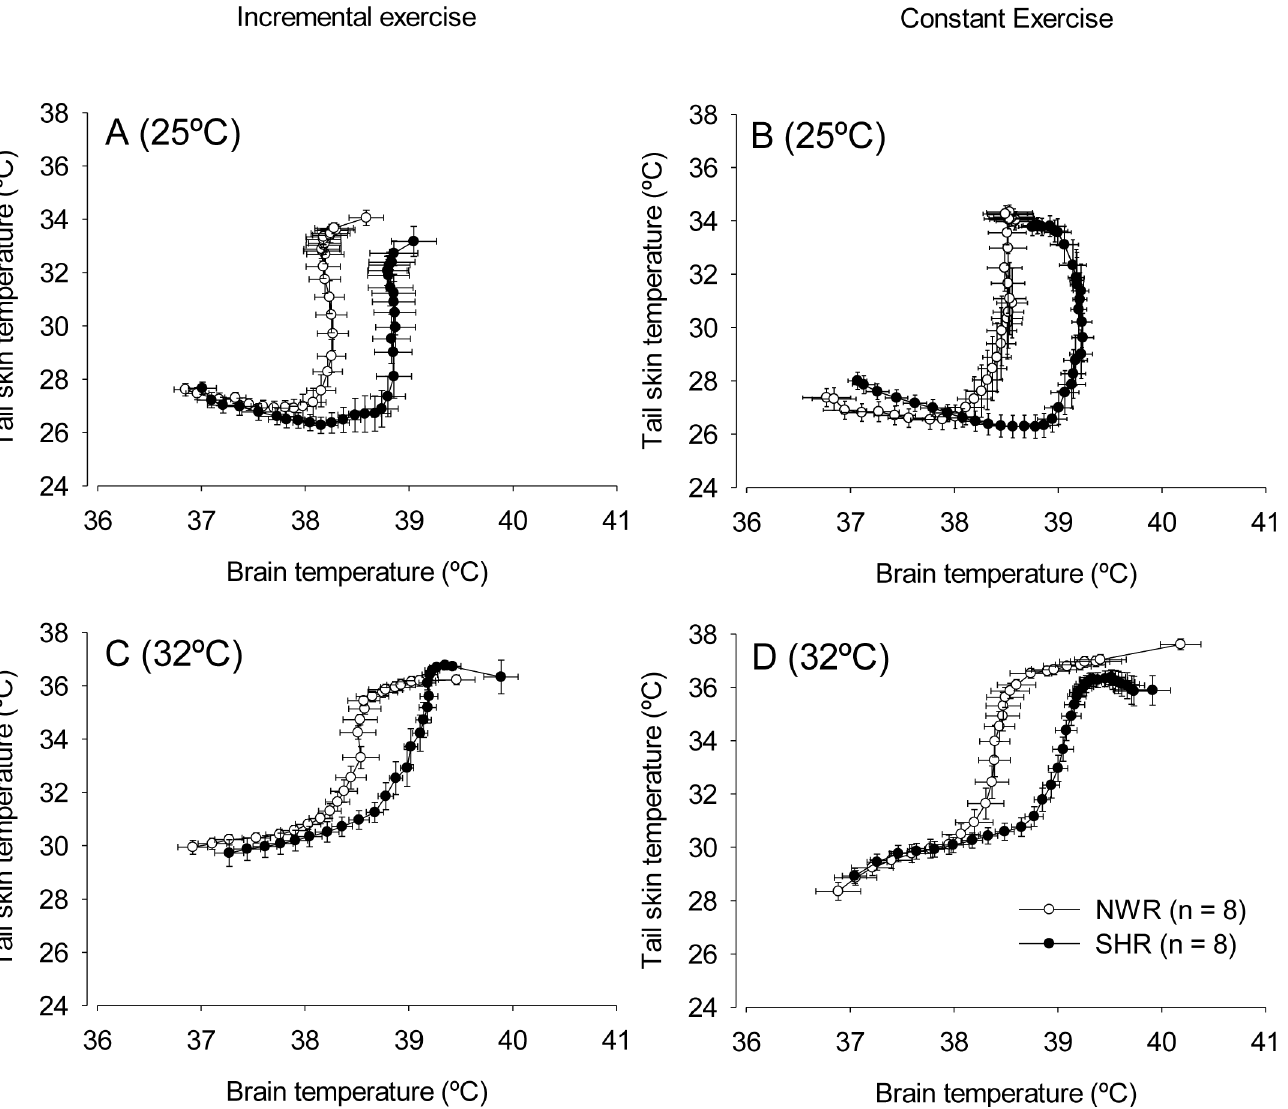
Fig 4. Thermoeffector activity during exercise. Thermoeffector activity during incremental (panels A and C) or constant (panels B and D) exercise in temperate (panels A and B) or warm (panels C and D) environments. Data are expressed as the mean ±